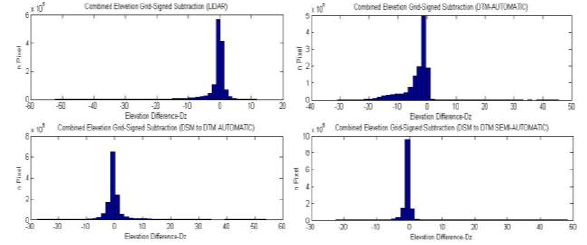
Figure 2. Histogram comparison of each method on map sheet 1209-1415C